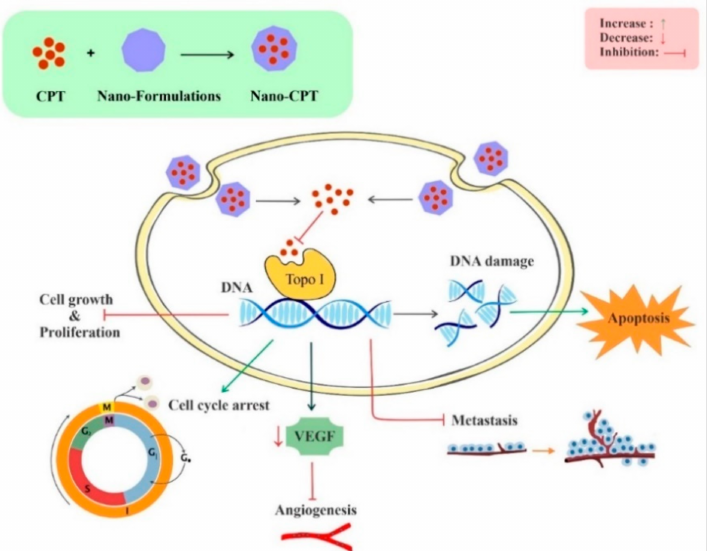
Figure 4. Molecularmechanisms underlying antitumor effects of CPT nano-formulations. Abbrevia- tions: CPT, camptothecin; Topo I, topoisomerase I; VEGF, vascular endothelial growth